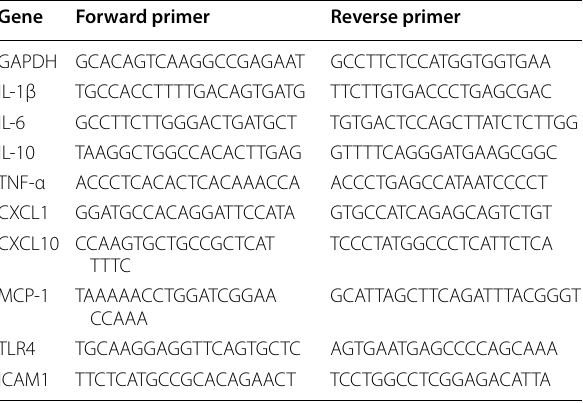
Table 1 Mouse primer sequences for the real-time PCR Gene